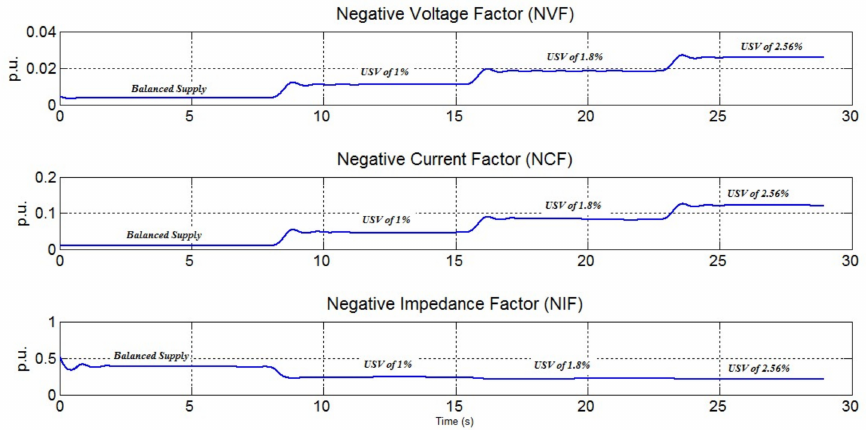
Figure 7. Time evolution of the defined factors for different USV’s levels at no load.